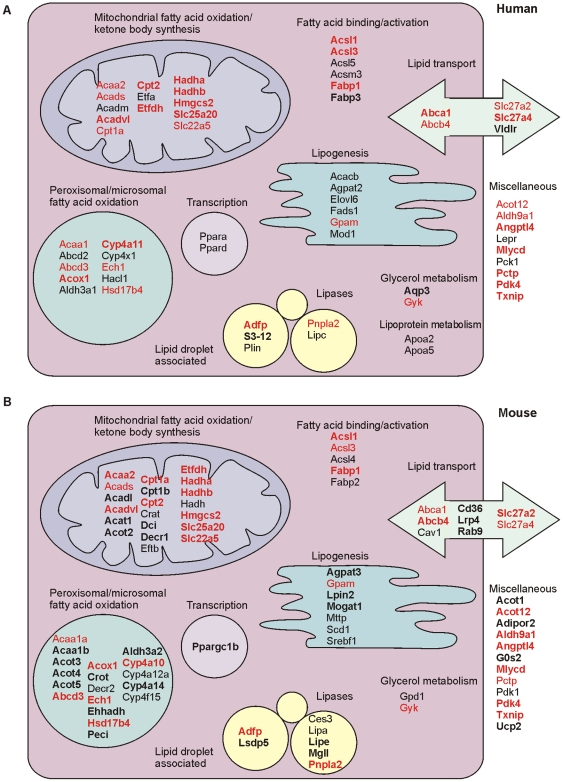
PPARα serves as a global transcriptional regulator of lipid metabolism in mouse and human hepatocytes.Genes significantly upregulated by Wy14643 and that function in lipid metabolism were classified into specific metabolic pathways. Separate pictures were created for human hepatocytes (A) and mouse hepatocytes (B). Genes significantly upregulated by Wy14643 at both time points of 6 h and 24 h are shown in bold. Genes significantly upregulated by Wy14643 in human and mouse hepatocytes are shown in red. Genes significantly upregulated by Wy14643 at one time point only are shown in normal font. Functional classification is based on a self-made functional annotation system of genes involved in lipid metabolism.